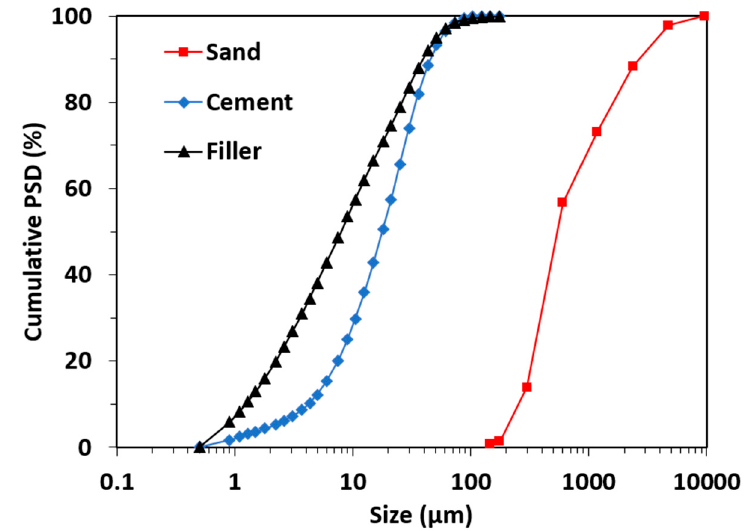
Figure 1. Cumulative particle size distribution of the cement powders, filler powders and sand used in this study.